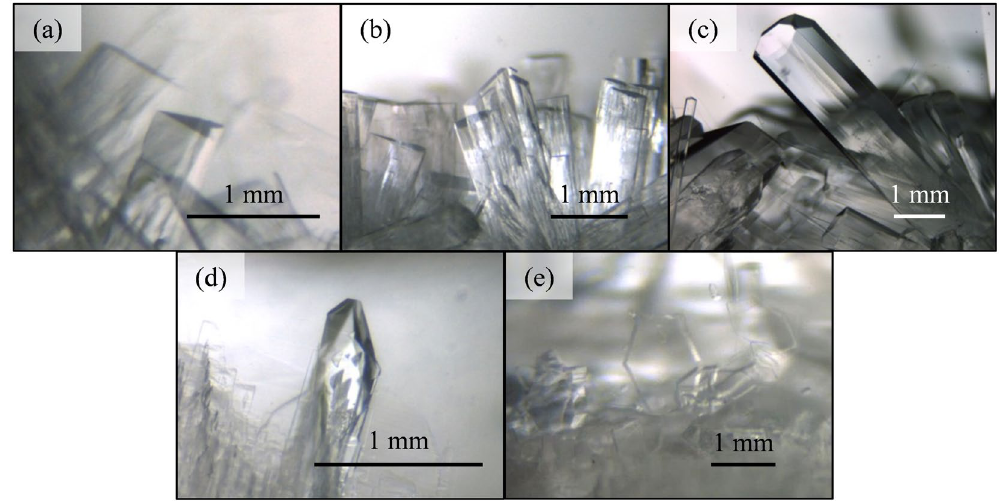
Figure 5. Single crystals of ionic clathrate hydrates formed with CO 2 + N 2 under static conditions. ( a ) CO 2 + N 2 + TBAB hydrate with w = 0.320 formed at 286.6 K and 5.08 MPa; ( b ) CO 2 + N 2 + TBAB hydrate with w = 0.200 formed at 284.2 K and 5.04 MPa; ( c ) CO 2 + N 2 + TBAC hydrate with w = 0.200 formed at 287.2 K and 5.03 MPa; ( d ) CO 2 + N 2 + TBPB hydrate with w = 0.200 formed at 285.2 K and 4.93 MPa; ( e ) CO 2 + N 2 + TBPC hydrate with w = 0.200 formed at 285.2 K and 5.09